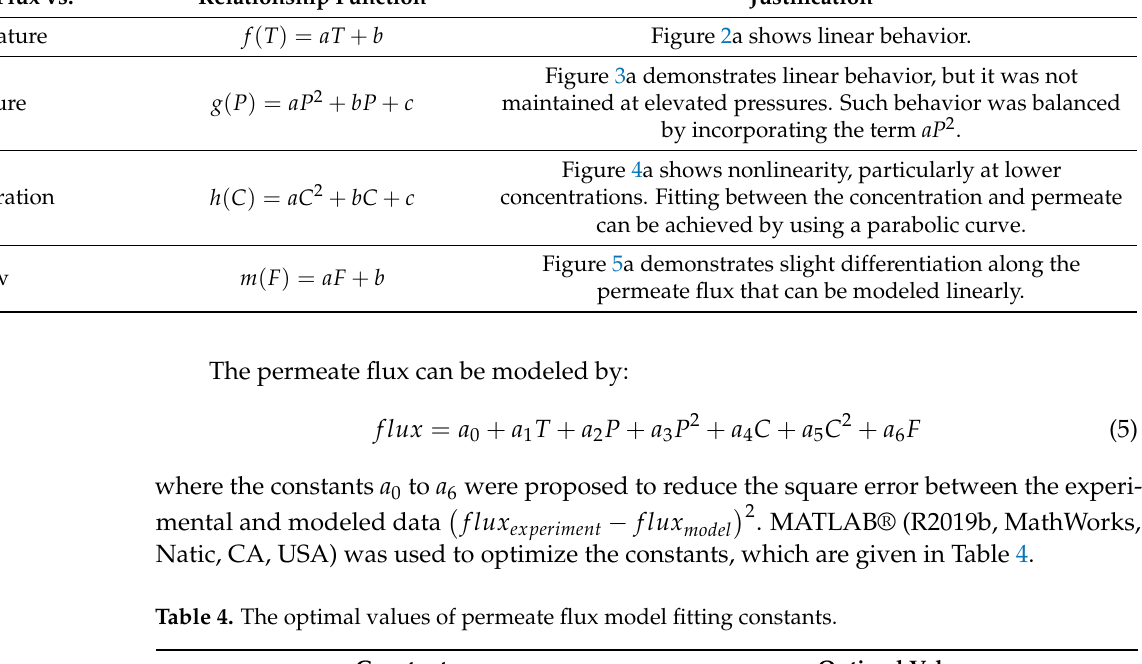
maintained at elevated pressures. Such behavior was balanced by incorporating the term aP 2 . concentrations. Fitting between the concentration and permeate can be achieved by using a parabolic curve.